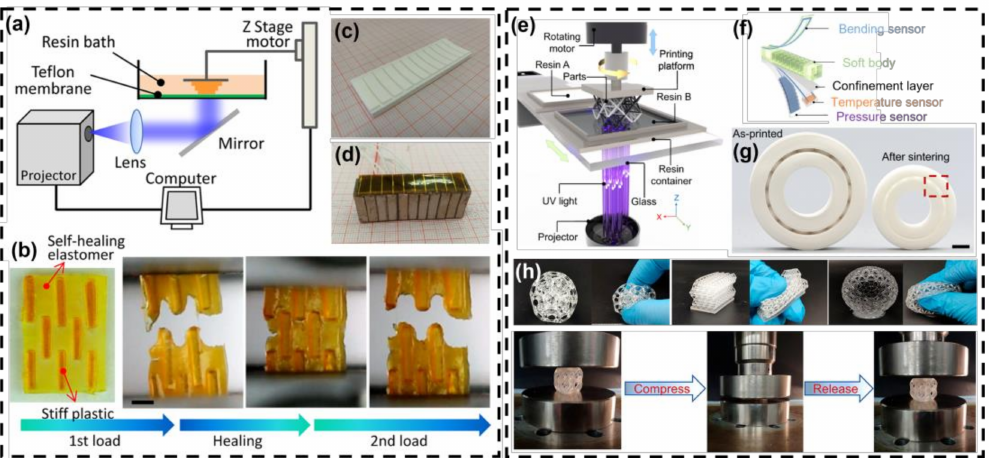
Figure 2. ( a ) SLA-based AM process. ( b ) Self-healable 3D soft actuator. A notched stiff-soft